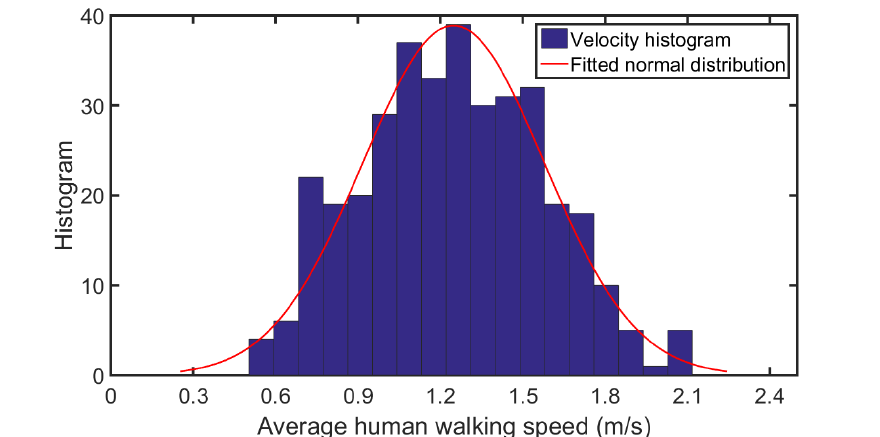
Figure 2. Distribution of average walking